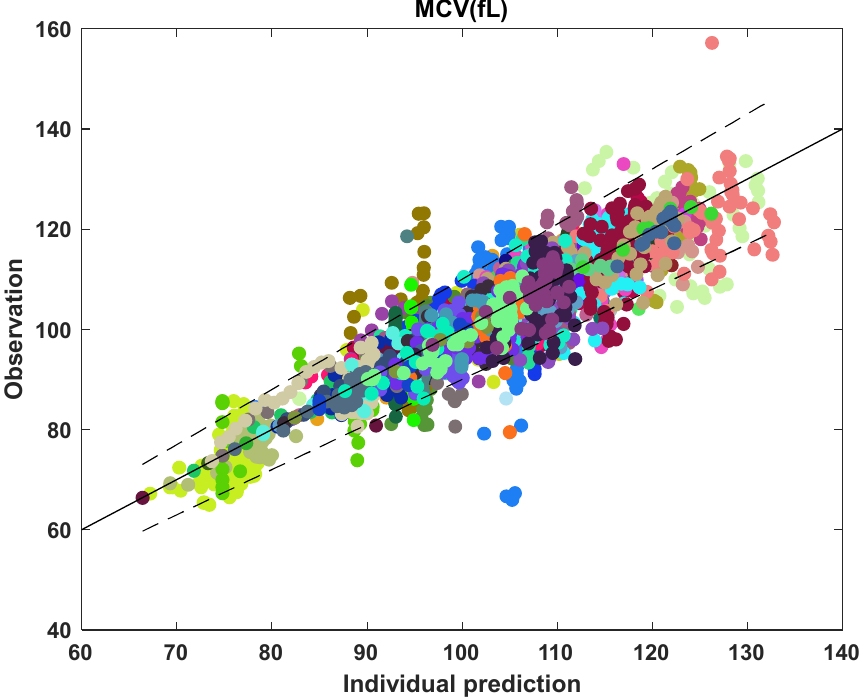
Figure 12. Goodness-of-fit plot for all MCV data points, where each color marks an individual participant. The solid line represents y = x; the dashed lines represent 10% error.